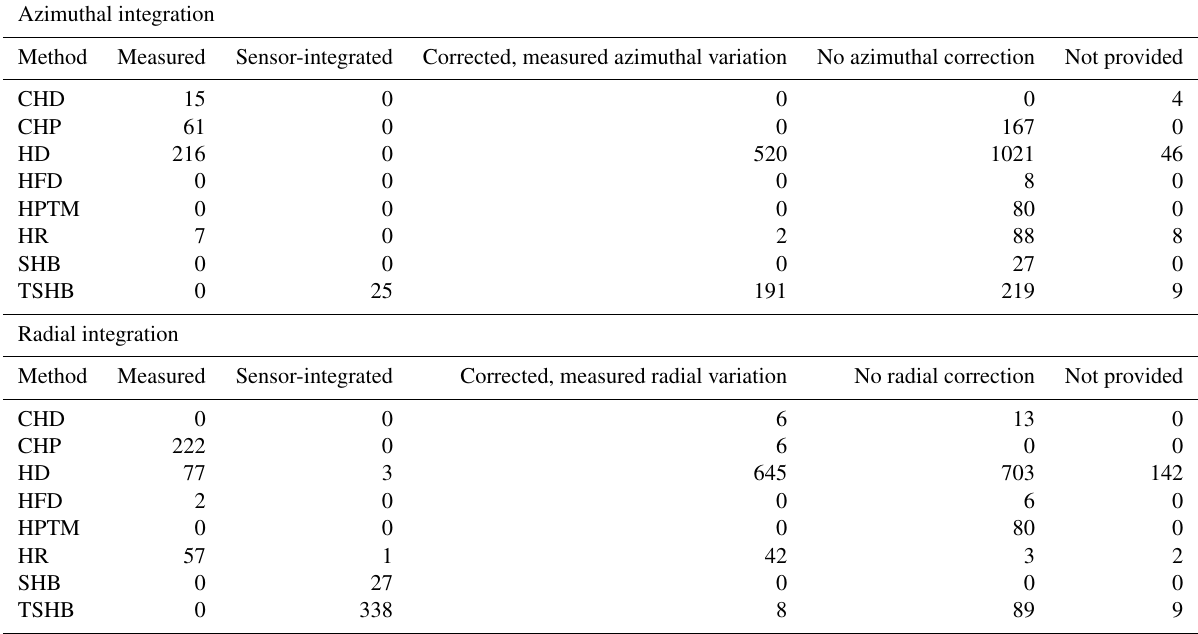
Table 2. Number of plants in the SAPFLUXNET database using different radial and azimuthal integration approaches for the different sap flow methods: cyclic (or transient) heat dissipation (CHD), compensation heat pulse (CHP), heat dissipation (HD), heat field